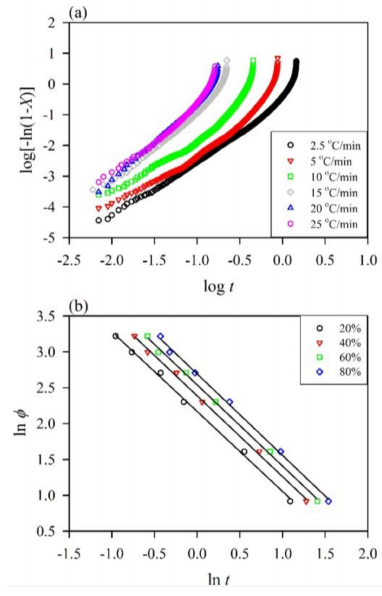
Figure 3. The non-isothermal crystallization kinetics of the neat PP. ( a ) Avrami plots of log[–ln(1– X )] versus log t ; ( b ) Avrami–Ozawa plots of ln φ versus ln t